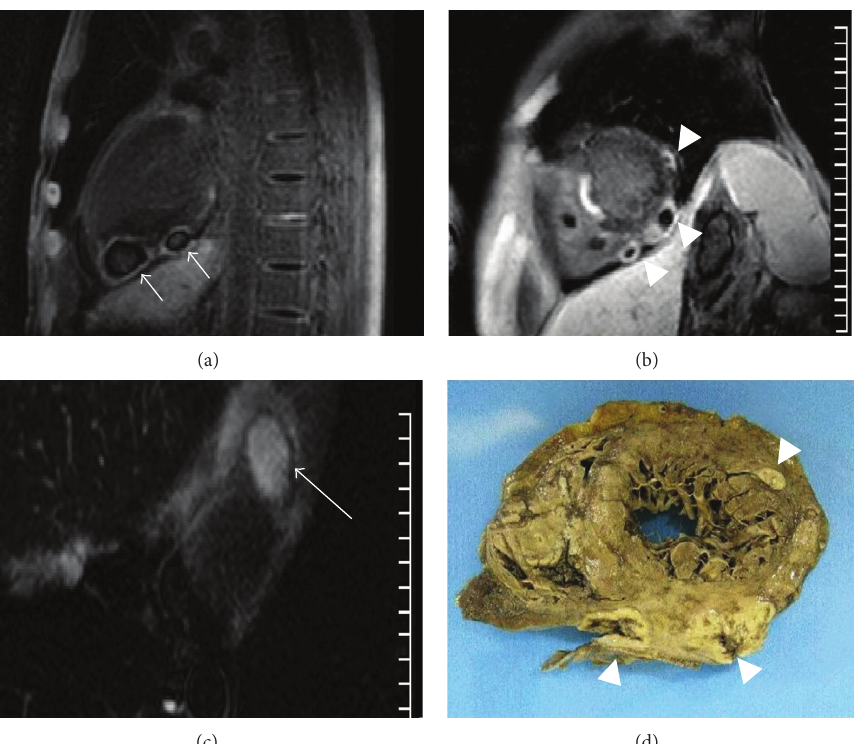
Figure 1: Cardiac MRI performed 6 months after diagnosis and autopsy study. (a) T1-weighted postgadolinium MRI—long axis view. Two collections (white arrows) with thick enhancing rim and hypointense core in the epicardium and myocardium of the left ventricle posterior wall. (b) T1-weighted postgadolinium MRI—short axis view. Lesions (arrow heads) in the left ventricle wall. A hyperintense calcified lesion located in the interventricular septum is also visualized. (c) T2-black blood MRI—axial view. Hyperintense core suggesting a cystic core (black arrow). (d) Autopsy study. Heart short axis view pointing out the three left ventricle abscesses observed on image (b) (arrow heads).